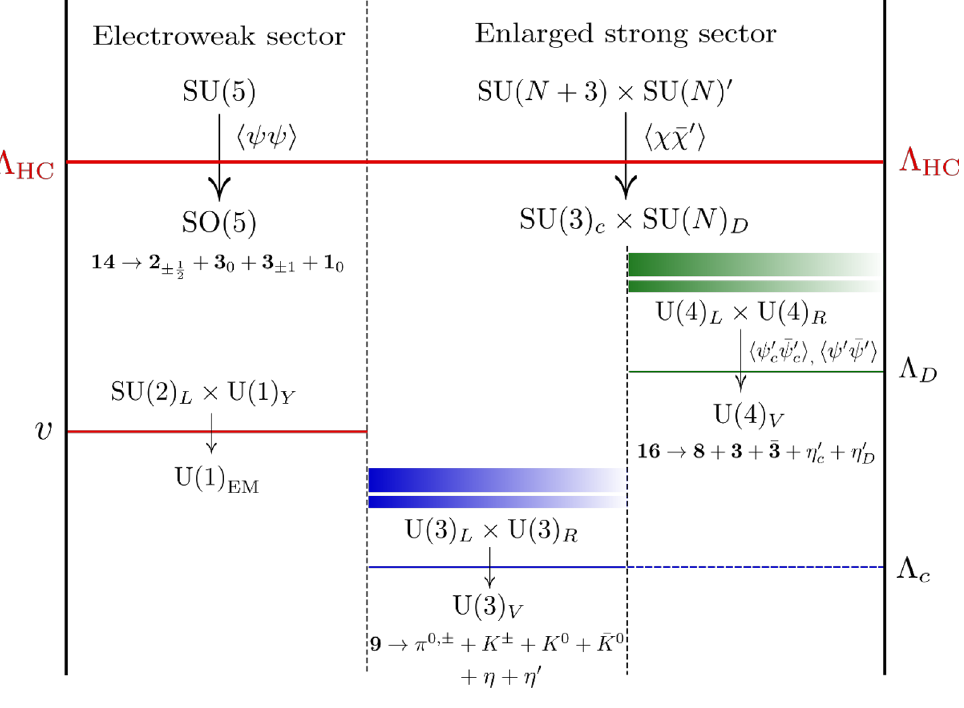
arise from the c,D